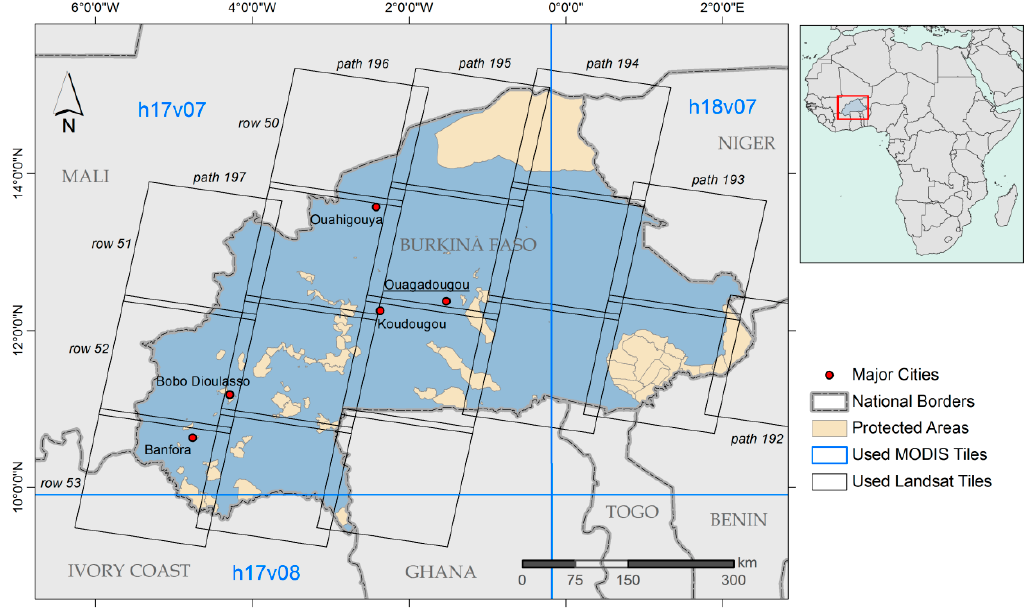
Figure 1. Study area of Burkina Faso showing the position of the used Landsat and MODIS tiles.